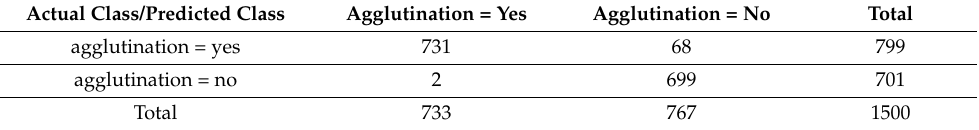
Table 11. Confusion matrix for the ORB algorithm over the 1500 patches.